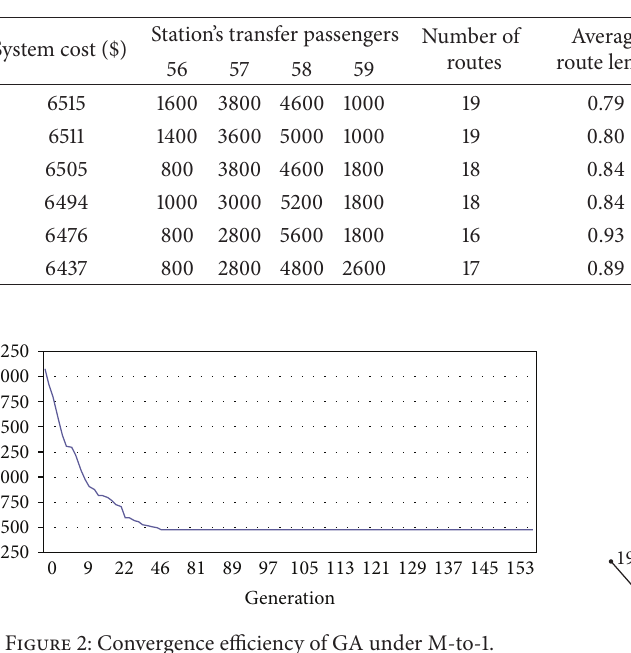
Table 4: Indicators of optimal solutions under various demand distributions.